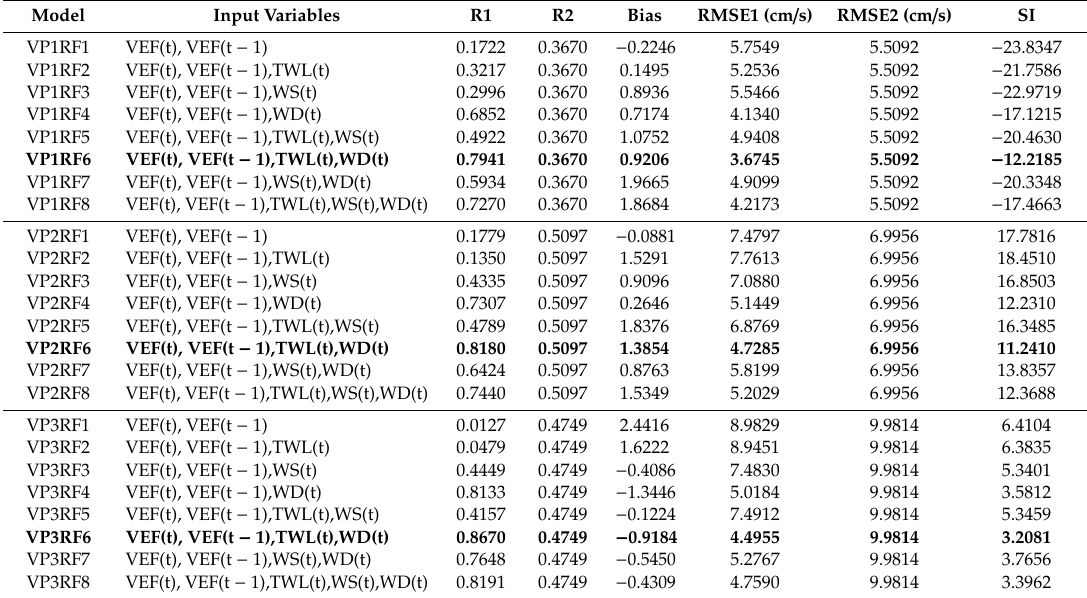
Table 5. Statistics of meridional surface velocity component (testing